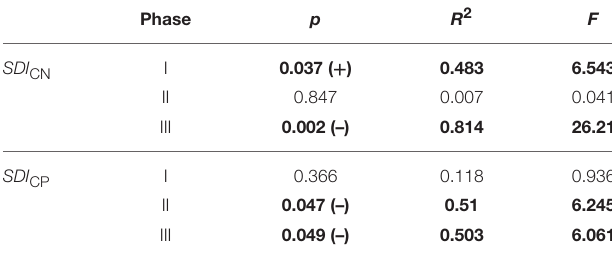
TABLE 3 | Statistical results from the linear regression analysis on response means over the respective phases. Phase